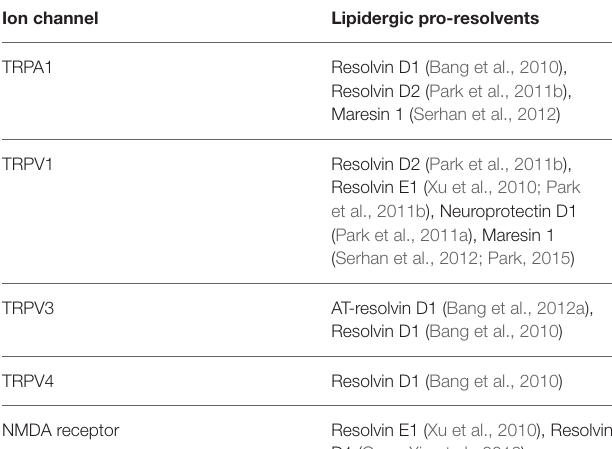
TABLE 1 | List of neuronal ion channels that are modulated by lipidergic